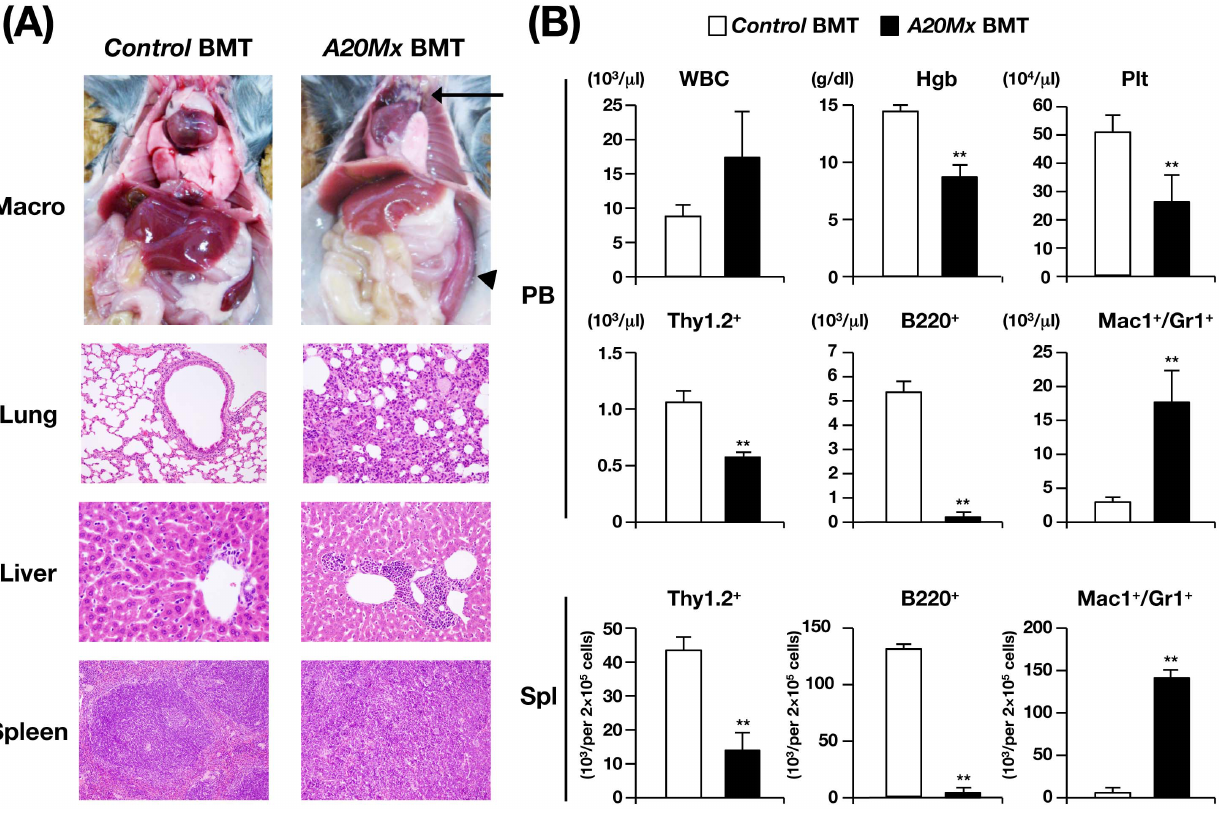
Figure 2. Analysis of A20Mx BMT mice. (A) Macroscopic appearance and pathological images of control BMT and A20Mx BMT mice. The atrophic thymus and enlarged spleen are indicated by an arrow and an arrowhead, respectively. Note the infiltrating hematopoietic cells in the lung and liver and the destruction of spleen architecture caused by excessive proliferation of myeloid cells in A20Mx BMT mice. (B) Time-dependent changes in hematopoietic parameters in the PB and spleen. **p , 0.01 (Student’s t -test).